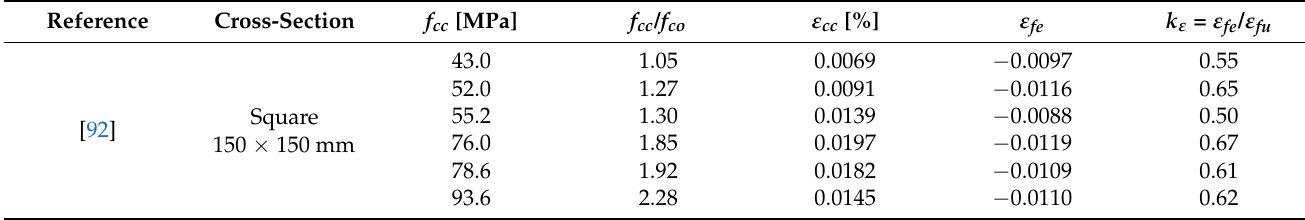
Table 5. Stress–strain results.